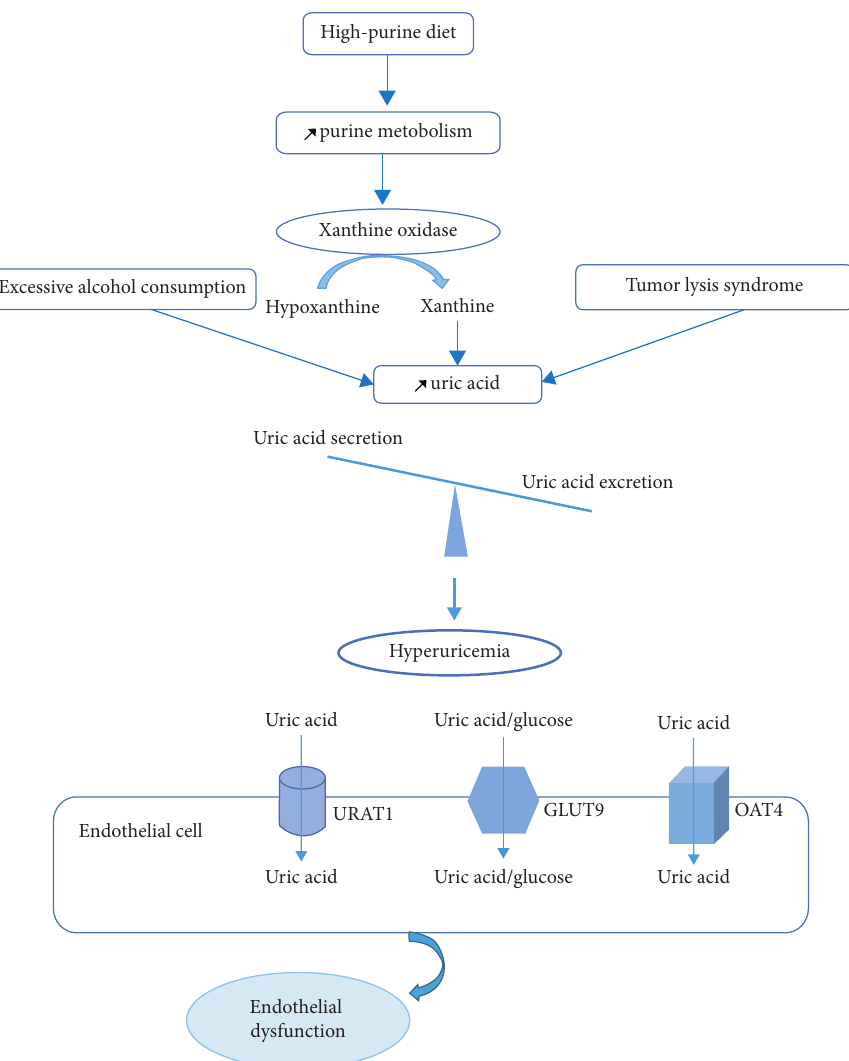
Figure 1: Mechanisms underlying